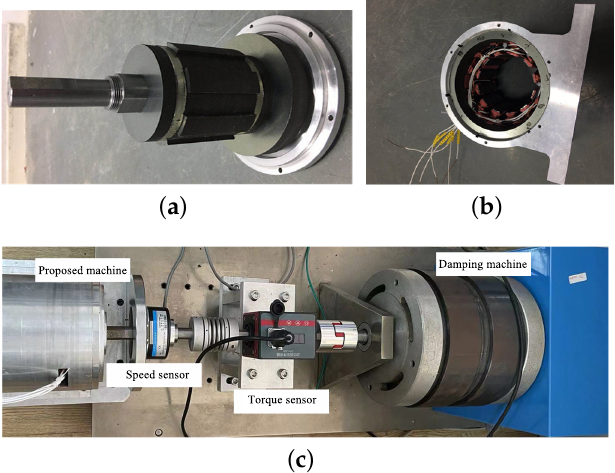
Figure 23. Prototype of the proposed machine. ( a ) Stator; ( b ) rotor; and ( c ) test bench.